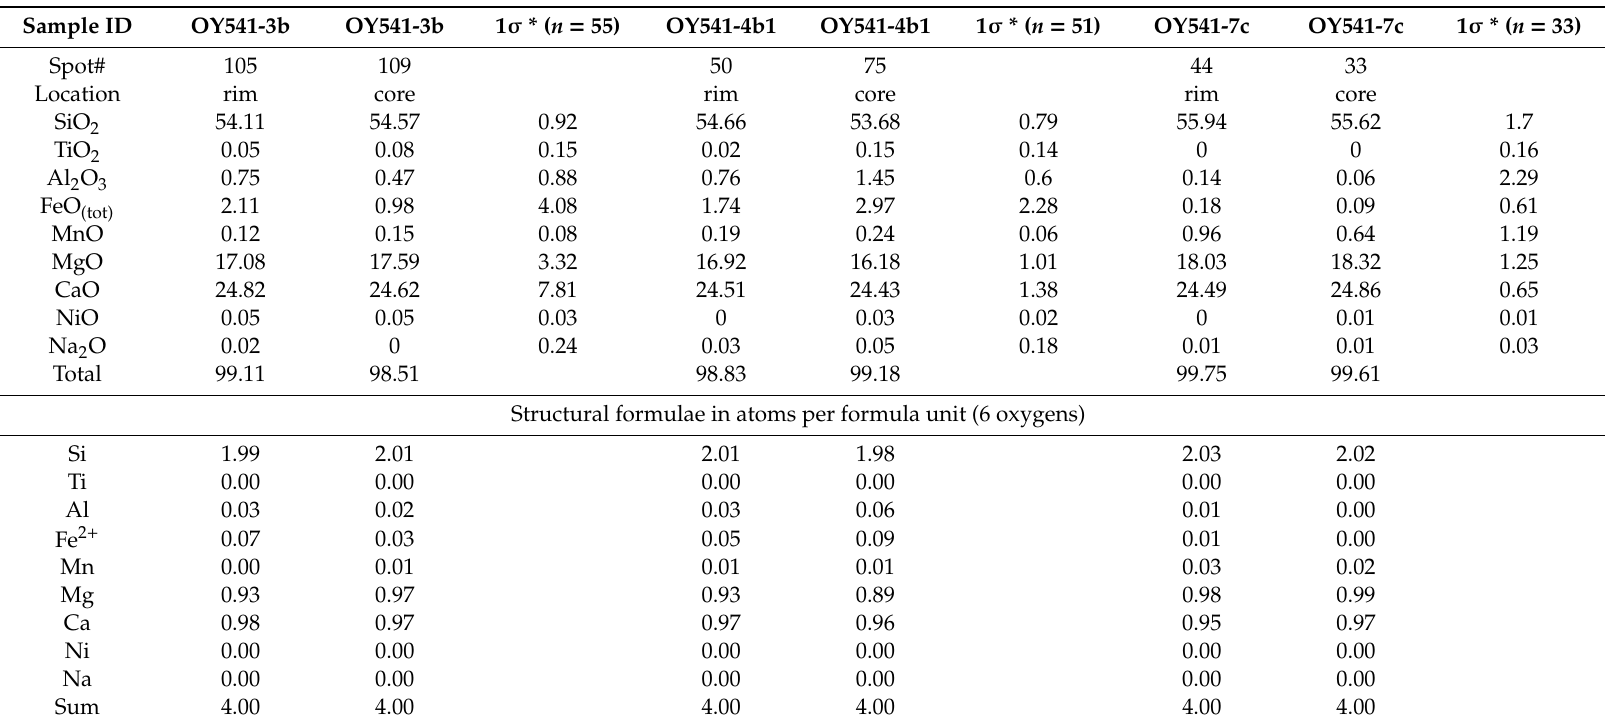
Table 2. Representative rim and core compositions of clinopyroxene measured by electron